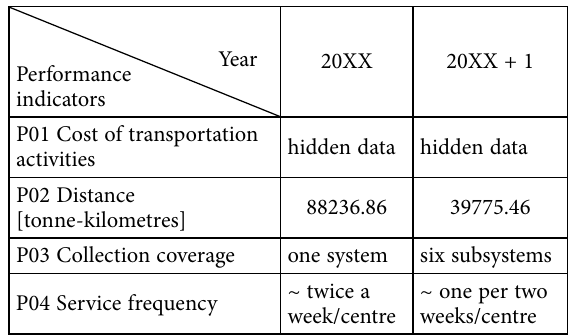
Table 3. Performance